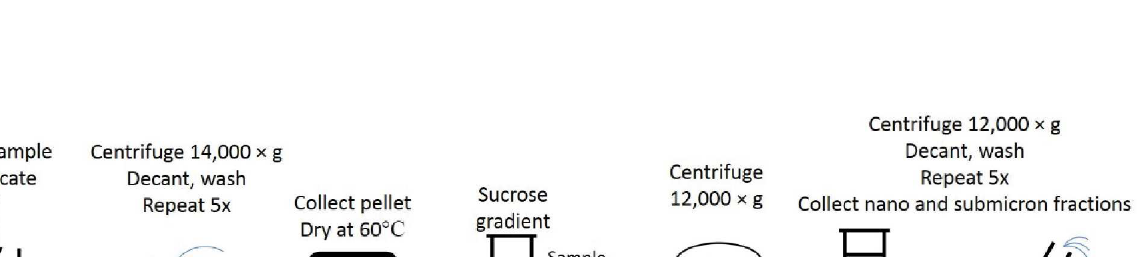
Fig 1. TEM primary particle analysis for TiO 2 found in selected foodstuffs and pharmaceuticals. (a) commercial-gradeE171 (b) chewinggum (c) name-brand allergy medicine,(d) generic allergymedicine, (e) name-brand pain reliever, and (f) generic pain reliever medicine.All images are shown at identical magnification. Scale bar in the lower right corner of each micrograph is 100 nm.